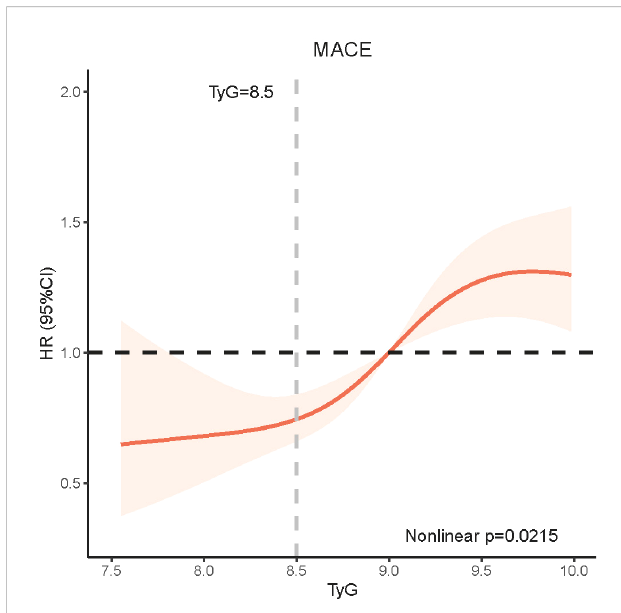
FIGURE 3 RCS model showing the association between the TyG quartiles and MACE.